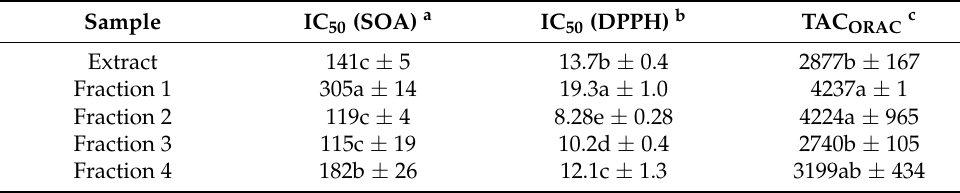
Table 2. Antioxidant activity of a green Cyclopia subternata hot water extract and fractions obtained from large-scale fractionation on XAD